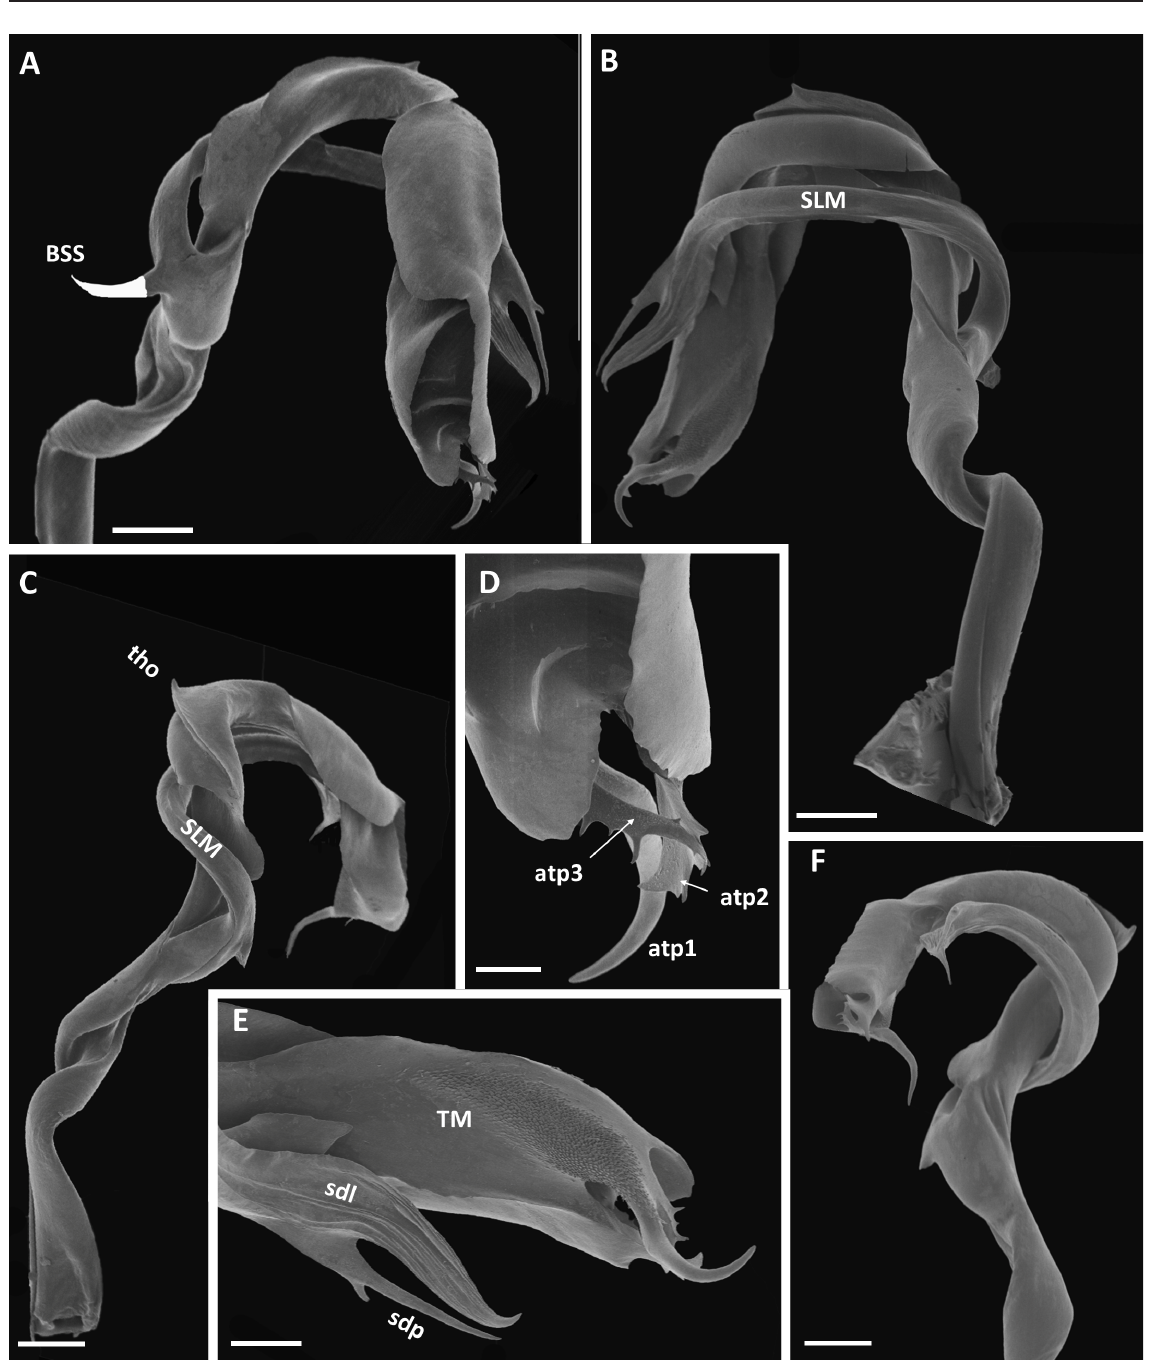
Fig. 72. Xystopyge minnae sp. nov., holotype, ♂ (NHMD 621770), left gonopod telopodite. A . Anterior view. B . Posterior view. C . Ventral view. D . Tip of telomere, anterior view. E . Tip of solenomere and telomere, posterior-mesal view. F . Dorsal view. Abbreviations: atp1 , atp2 , atp3 = apical telomeral processes; BSS = basal solenomeral spine (reconstructed); sdl = solenomeral distal microstriate branch; sdp = solenomeral distal spinelike branch; SLM = solenomere; tho = telomeral thornlike outgrowth; TM = telomere Scale bars: A–C, F = 0.2 mm; D = 0.05 mm; E = 0.1